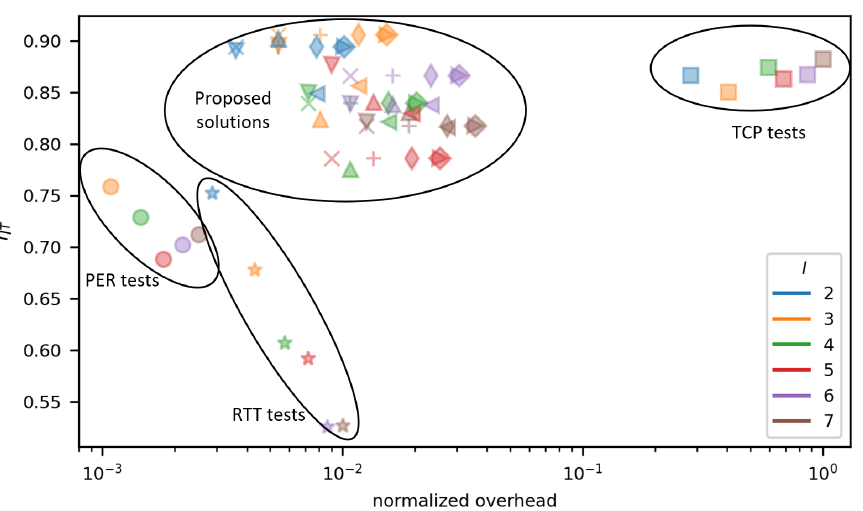
Figure 18. η T over overhead for evaluated methods: (cid:4) —TCP; (cid:70) —RTT; • —PER; × —DLR-LEM M1; + —DLR-LEM M4; ♦ —DLR-LEM M8; (cid:5) —DLR-LEM M12; (cid:53) —SDL-LEM M1; (cid:52) —SDL-LEM M4; (cid:47) —SDL-LEM M8; (cid:46) —SDL-LEM